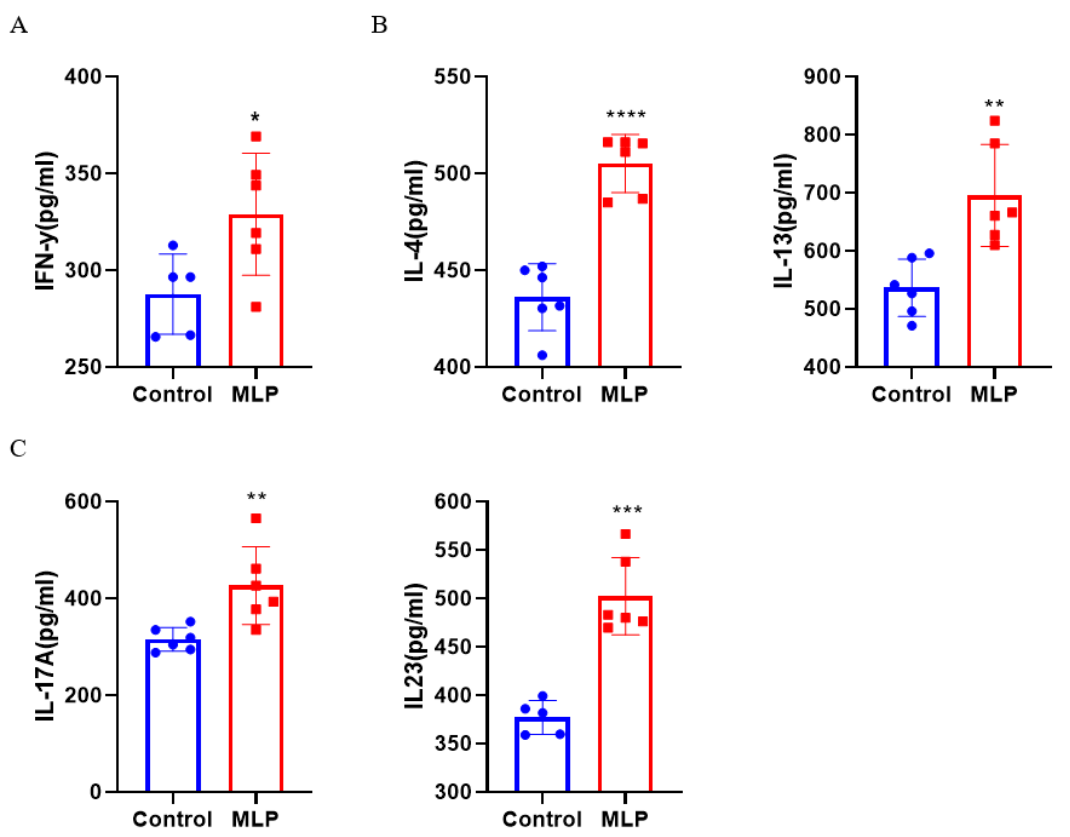
Figure 4. ( A ) Level of Th1 (IFN- γ ), ( B ) Th2 (IL-4 and IL-13), and ( C ) Th17 (IL-17A and IL-23) in MLP-sensitized mice sera by ELISA. Significant difference (* p < 0.05, ** p < 0.01, *** p < 0.001, **** p < 0.0001; n ≥ 5) compared with the control group.